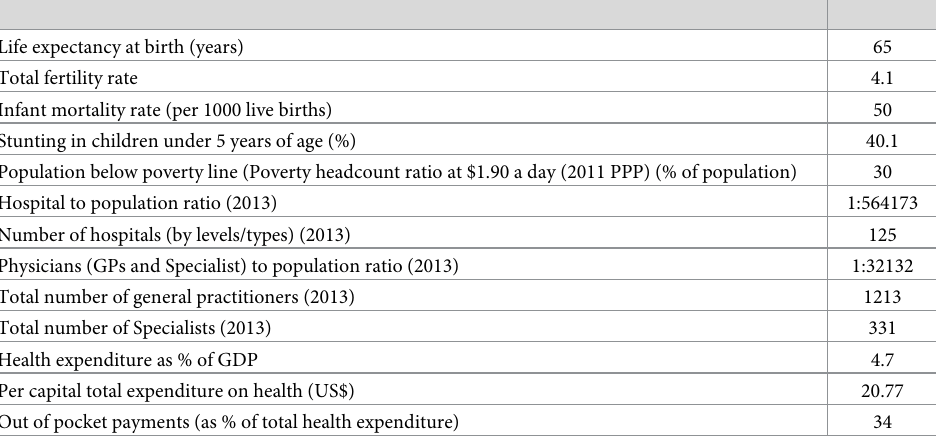
Table 1. Selected health, development and poverty indicators of ethiopia[7,